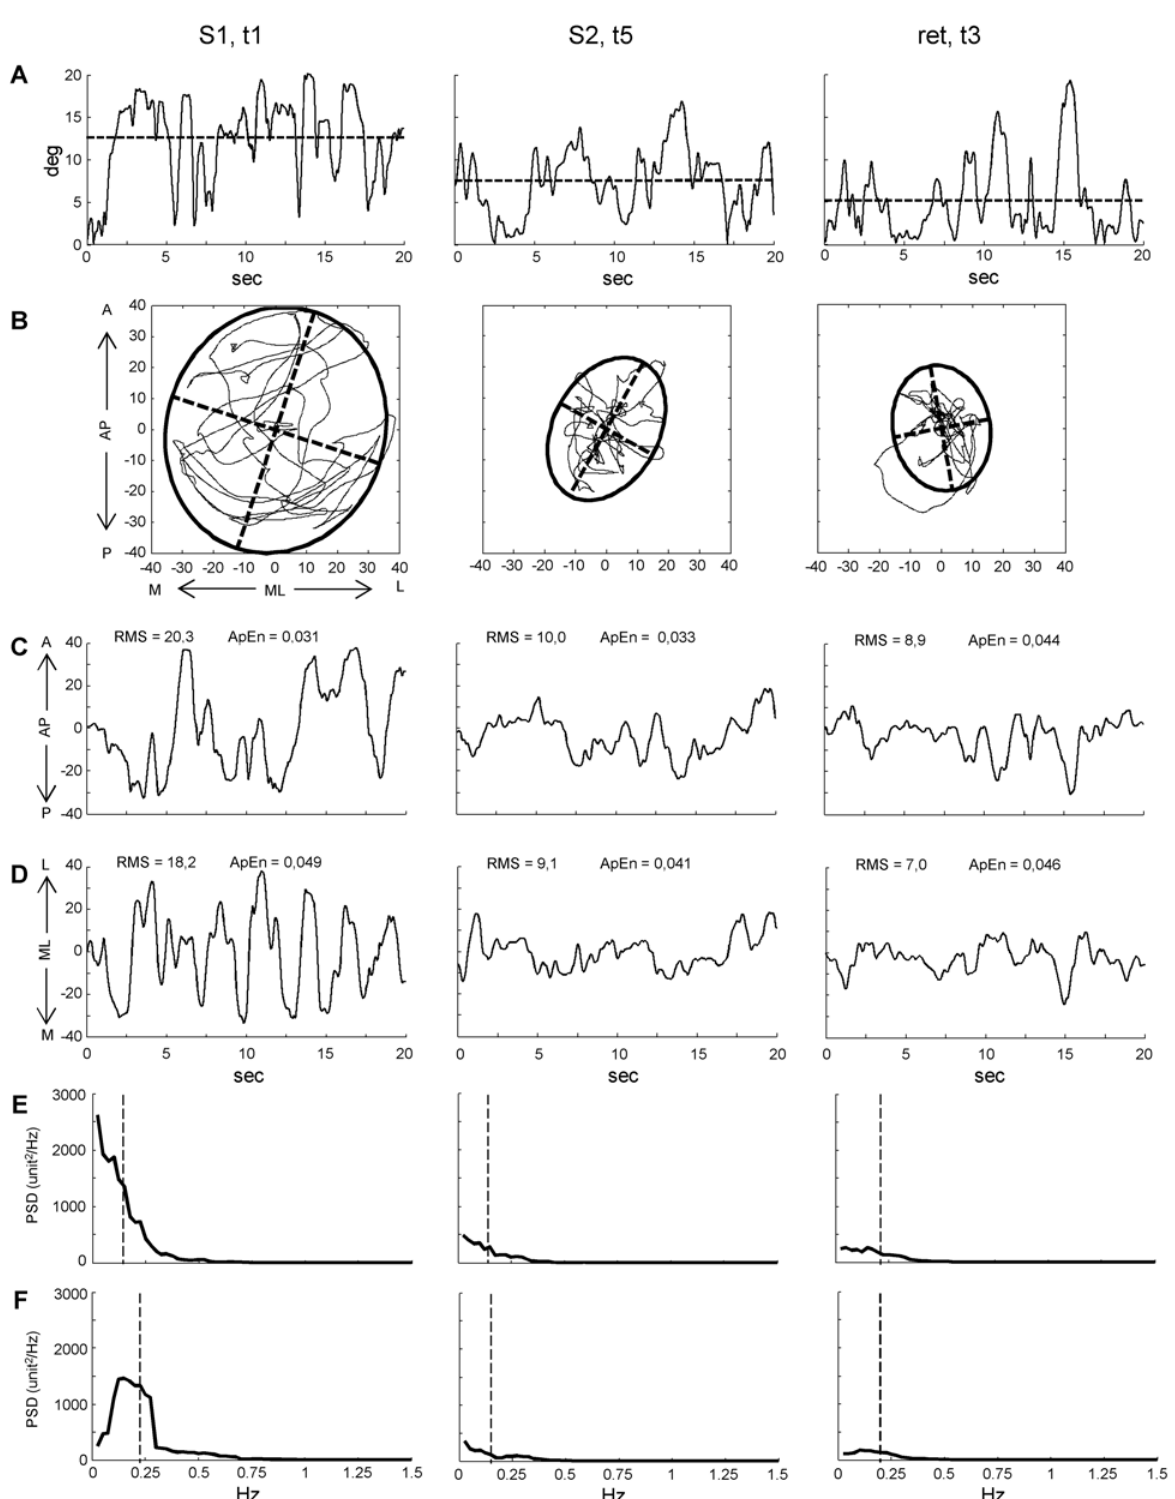
Fig 2. Representative example of the postural outcome. The plots illustrate the effect of practice on the balance board motion exhibited by one participant during three trials (t1, t5, t3) performed across three sessions (S1, S2, retention). (A) Amplitude of angular oscillations of the board around the horizontal